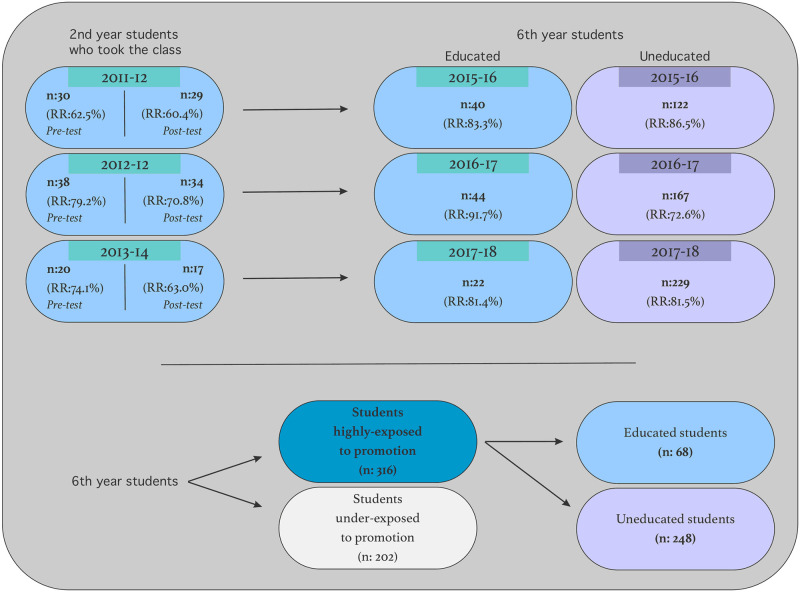
The study design.(RR: Response rate).